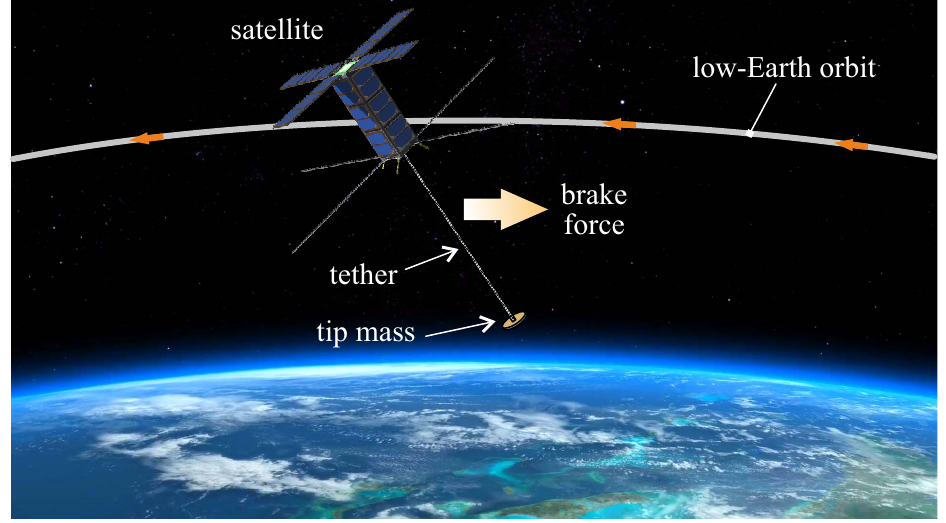
Figure 1. PB-device conceptual